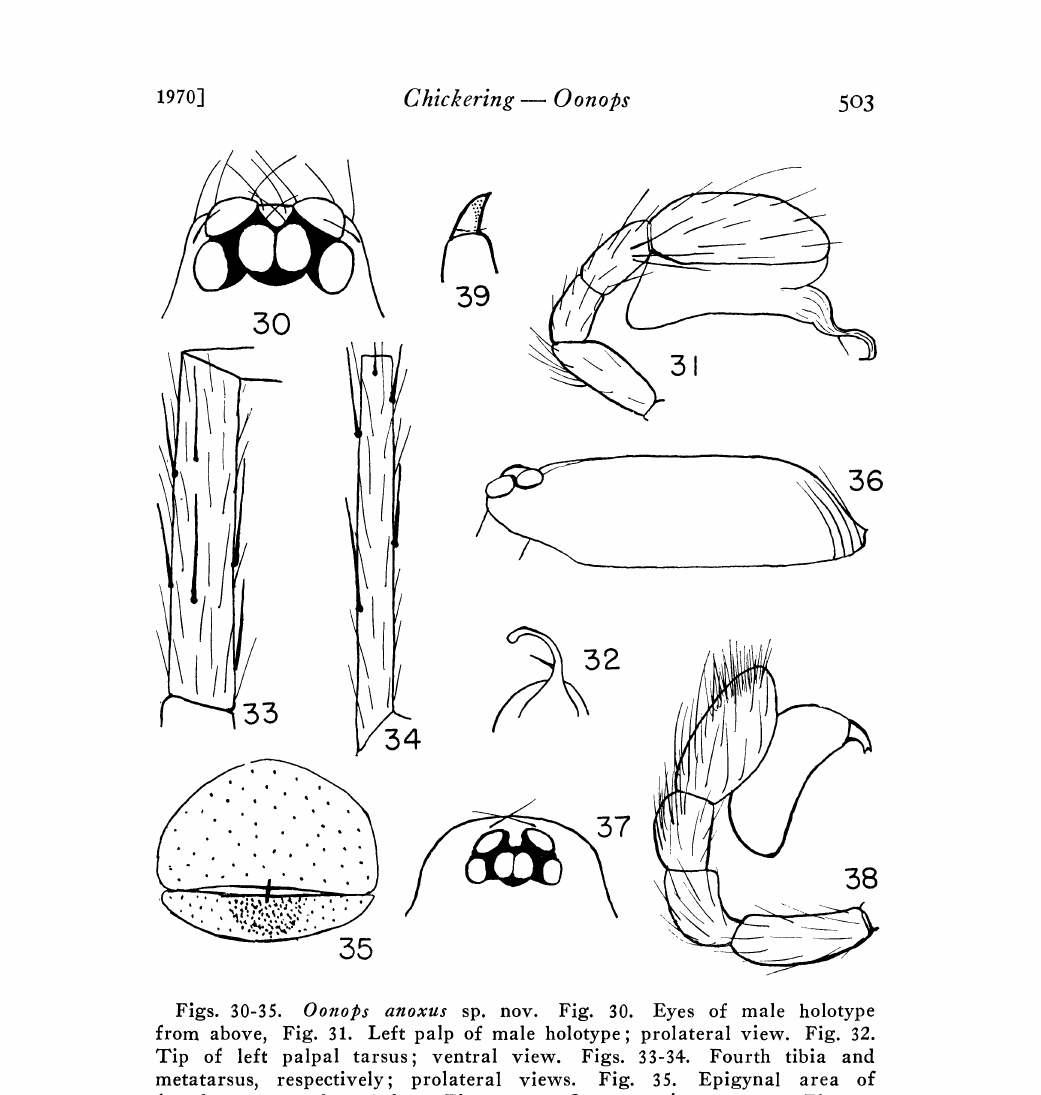
Figs. 30-35. Oonops anoxus sp. nov. Fig. 30. Eyes o male holotype from above, Fig. 31. Left palp of male holotype; prolateral view. Fig. 32. Tip o let palpal tarsus; ventral view. Figs. 33-34. Fourth tibia and metatarsus, respectively; prolateral views. Fig. 35. Epigynal area of female paratype from below. Figs. 36-39. Oonops satius sp. nov. Fig. 36. Carapace of paratype male; left lateral side. Fig. 37. Eyes of male holotype rom above. Fig. 38. Let palp of male holotype; prolateral view. Fig. 39. ,Tip o left palpal tarsus; nearly dorsal